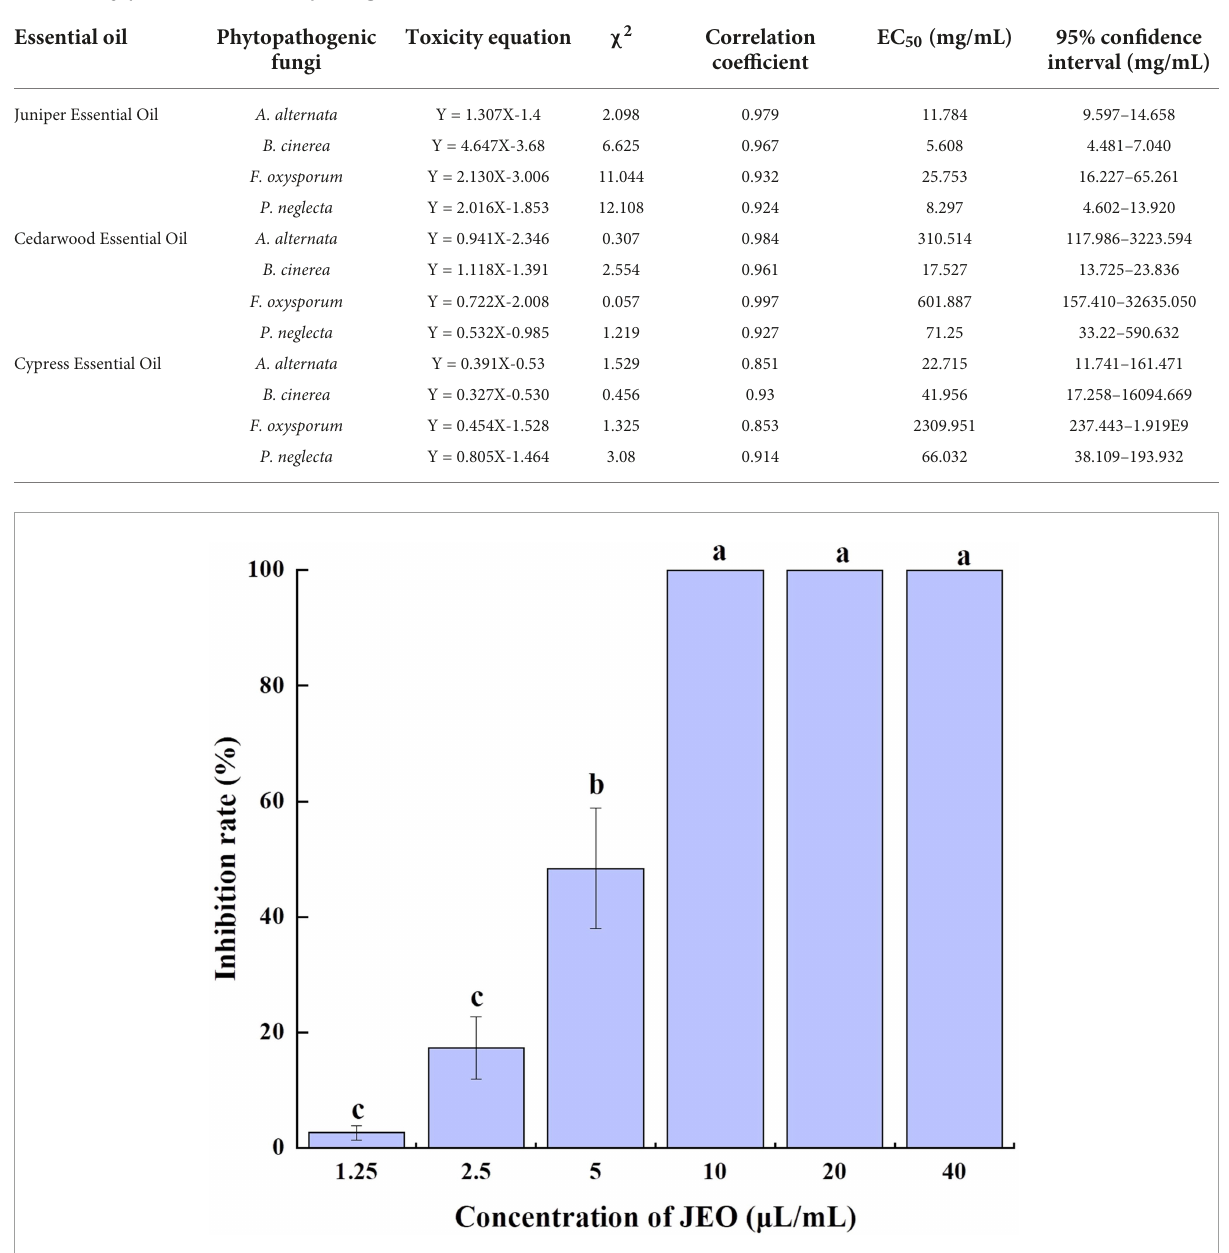
FIGURE2 Effects of different concentrations of JEO on the spore germination of B. cinerea . The spores were treated with JEO at different concentrations (0, 1.25, 2.5, 5, 10, 20, and 40 µ L/mL) and then incubated at 25 ◦ C for 12 h. The bars represent the standard error of the mean ( n = 3). Letters (a, b, c, d) represent statistically significant differences between different concentrations according to Duncan’s multiple range test ( P < 0.05). JEO, juniper essential oil.